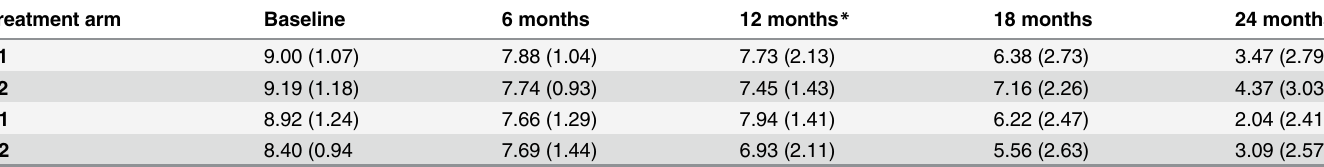
Table 9. Changes in antigenemia (OG 4 C 3 ) over period in the four arms:: Mean (SD) of log (OG4C) units for treatment over 24 months. Treatment